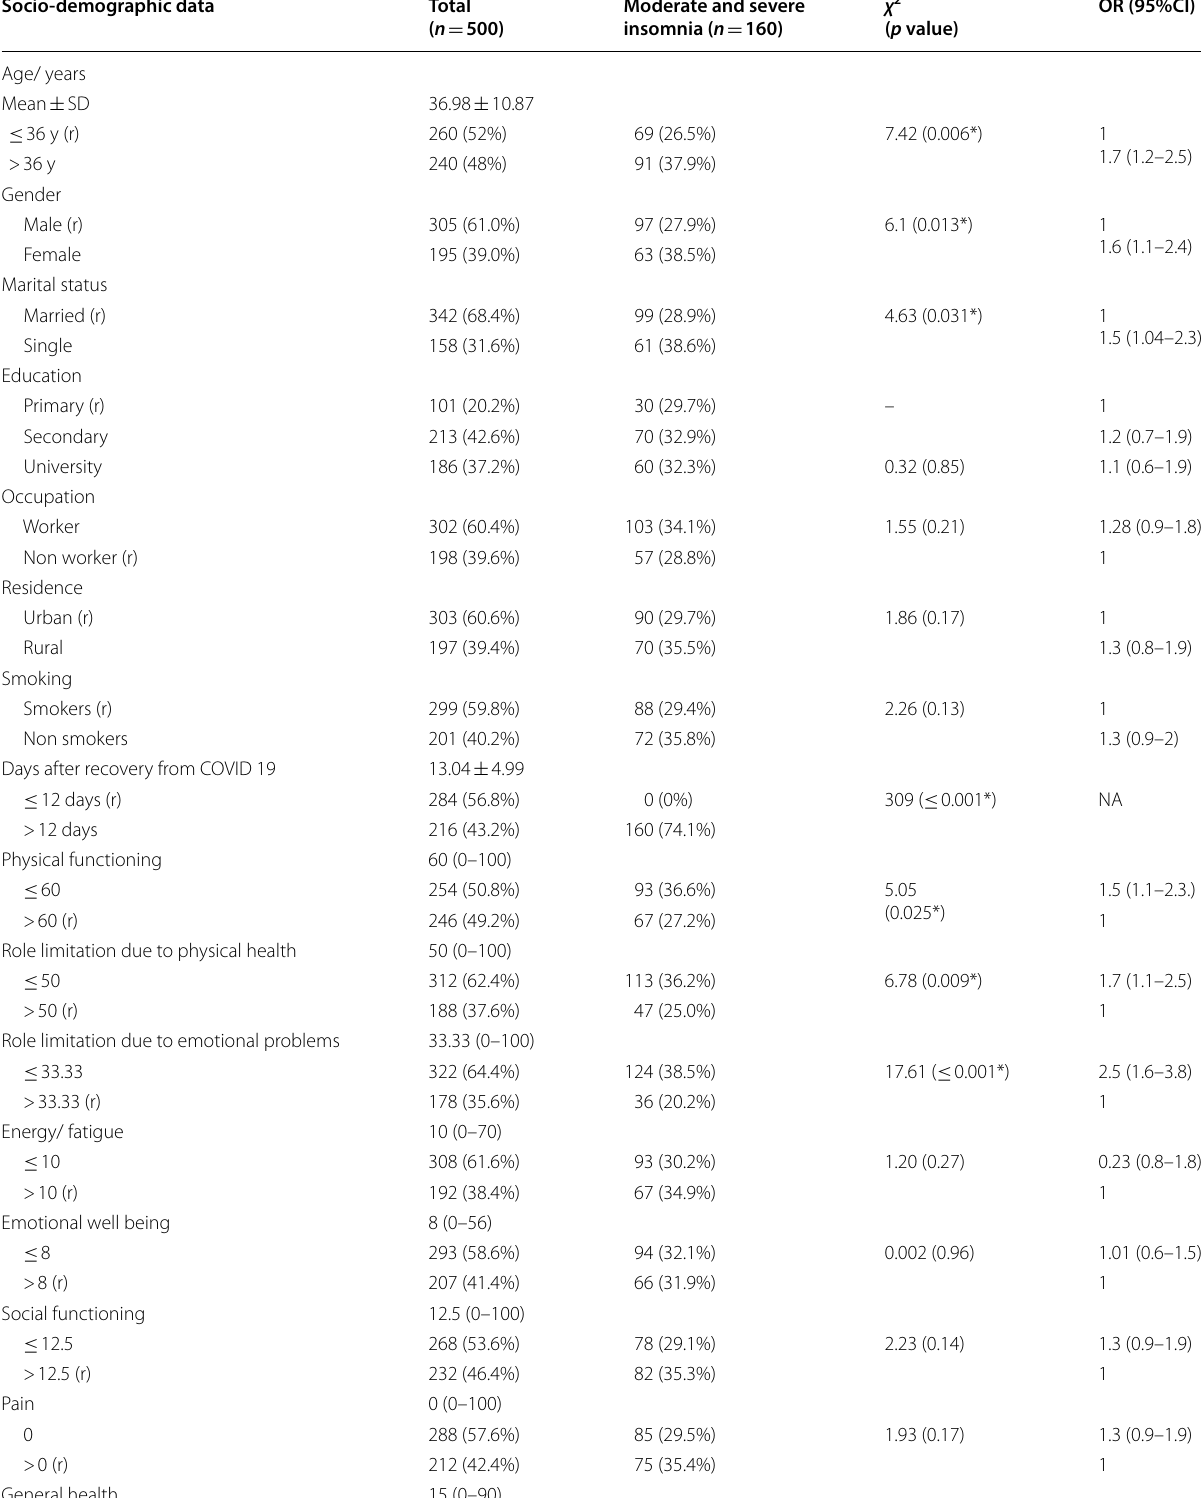
Table 4 Association between moderate, severe insomnia and patients’ characteristics Socio-demographic